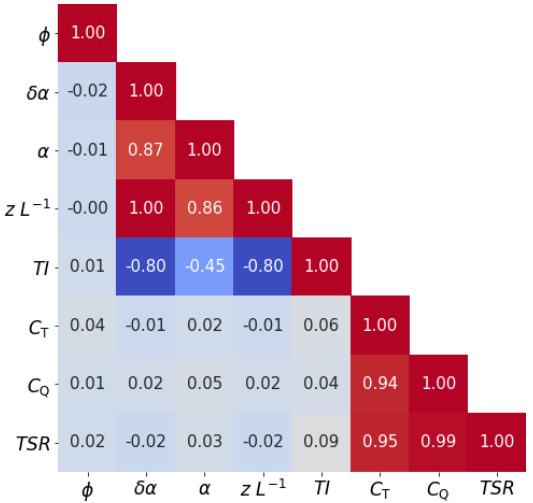
Figure 5. Correlation matrix of the dimensionless input parameters in LES. Colors indicate a positive (red) or negative (blue) correla-